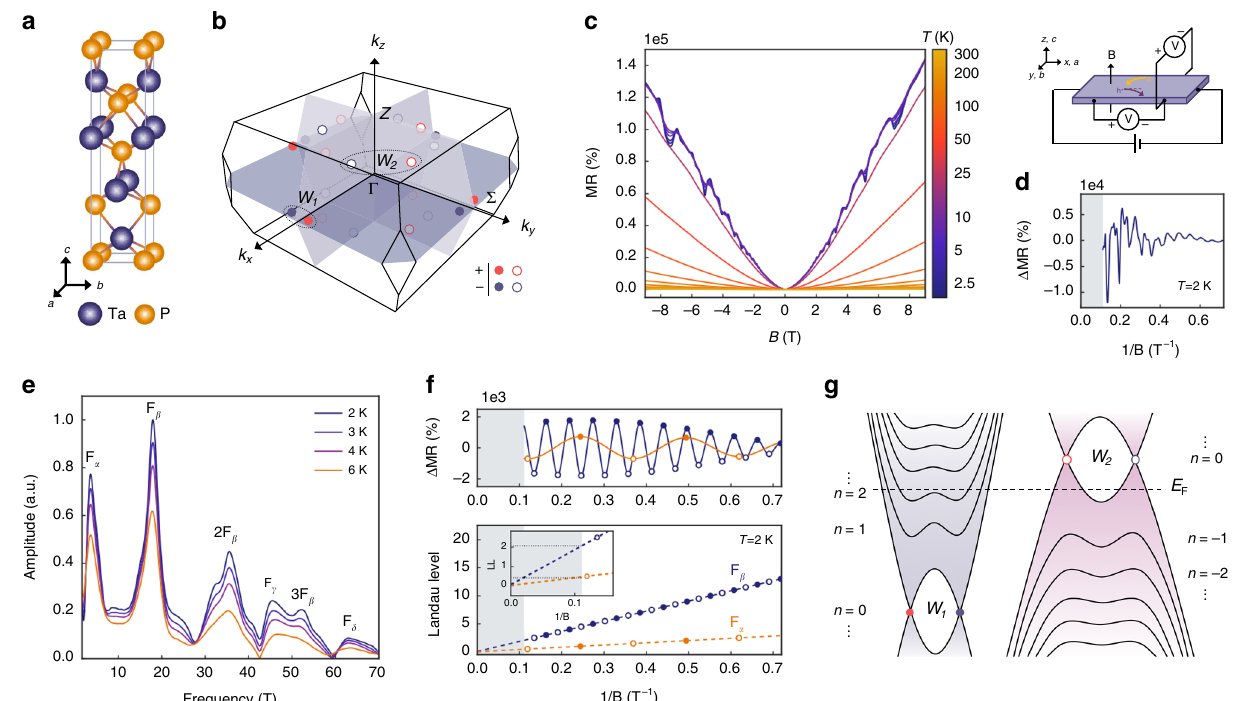
Fig. 1 Quantum oscillation of TaP. a The inversion-symmetry-breaking crystal structure and b the Brillouin zone of TaP, highlighting the locations of the inequivalent Weyl nodes W1 ( fi lled circles) and W2 (empty circles). The Weyl nodes are paired as source “ + ” (red) and sink “ − ” (blue) of Berry curvature, separated in momentum space. c Magnetoresistance (MR) as a function of magnetic fi eld at different temperatures from 2.5 K to 300 K. A high (>10 5 %) MR ratio is observed. d The MR measurement con fi guration (top) and Δ MR as a function of 1/B (bottom). e − and h + denote electrons and holes, respectively. e The Fourier transform of Δ MR showing a low oscillation frequency F α ¼ 4T. This is a signature that, in addition to the electron pocket from W1 Weyl node contributing to F β ¼ 18T, we are very close to the W2 Weyl node. f The SdH oscillation and Landau level index plot, from which we obtained an n = 2 Landau level and another n = 0 Landau level. g The schematic bandstructure at fi nite magnetic fi elds of our TaP